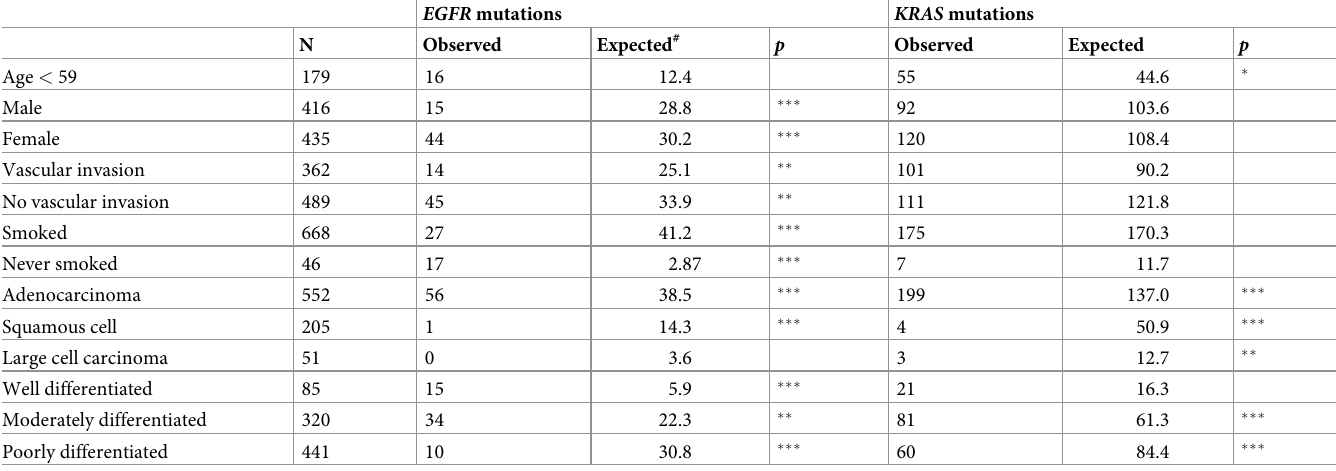
Table 2. A summary of all significant association between variables and gene mutations in lung cancer patients cohort.